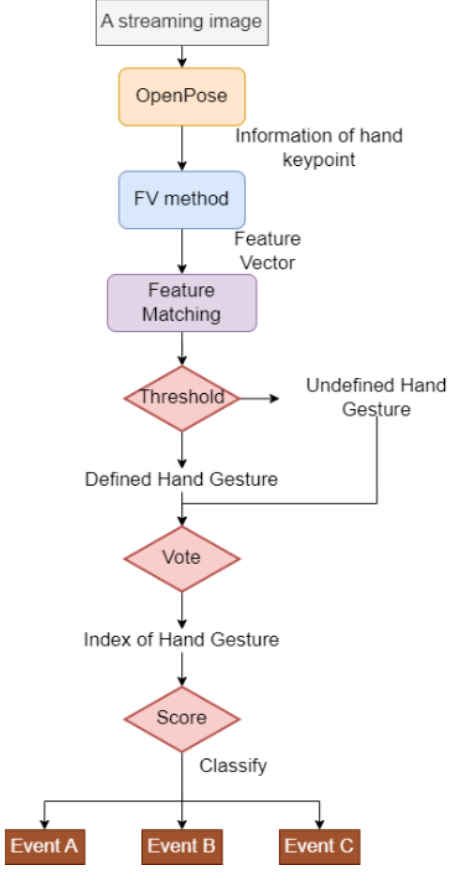
Figure 2. Schematic diagram of feature matching.